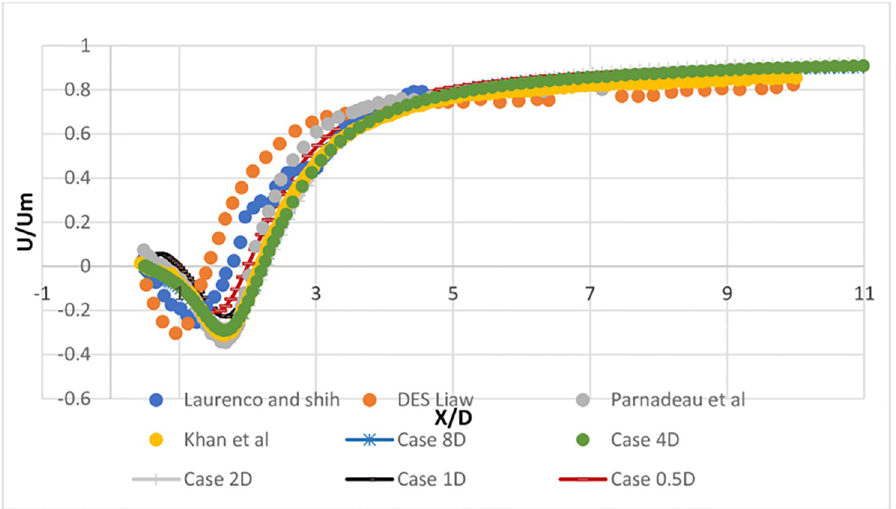
Fig 4. Mean stream velocity profile at centerline, behind the cylinder.